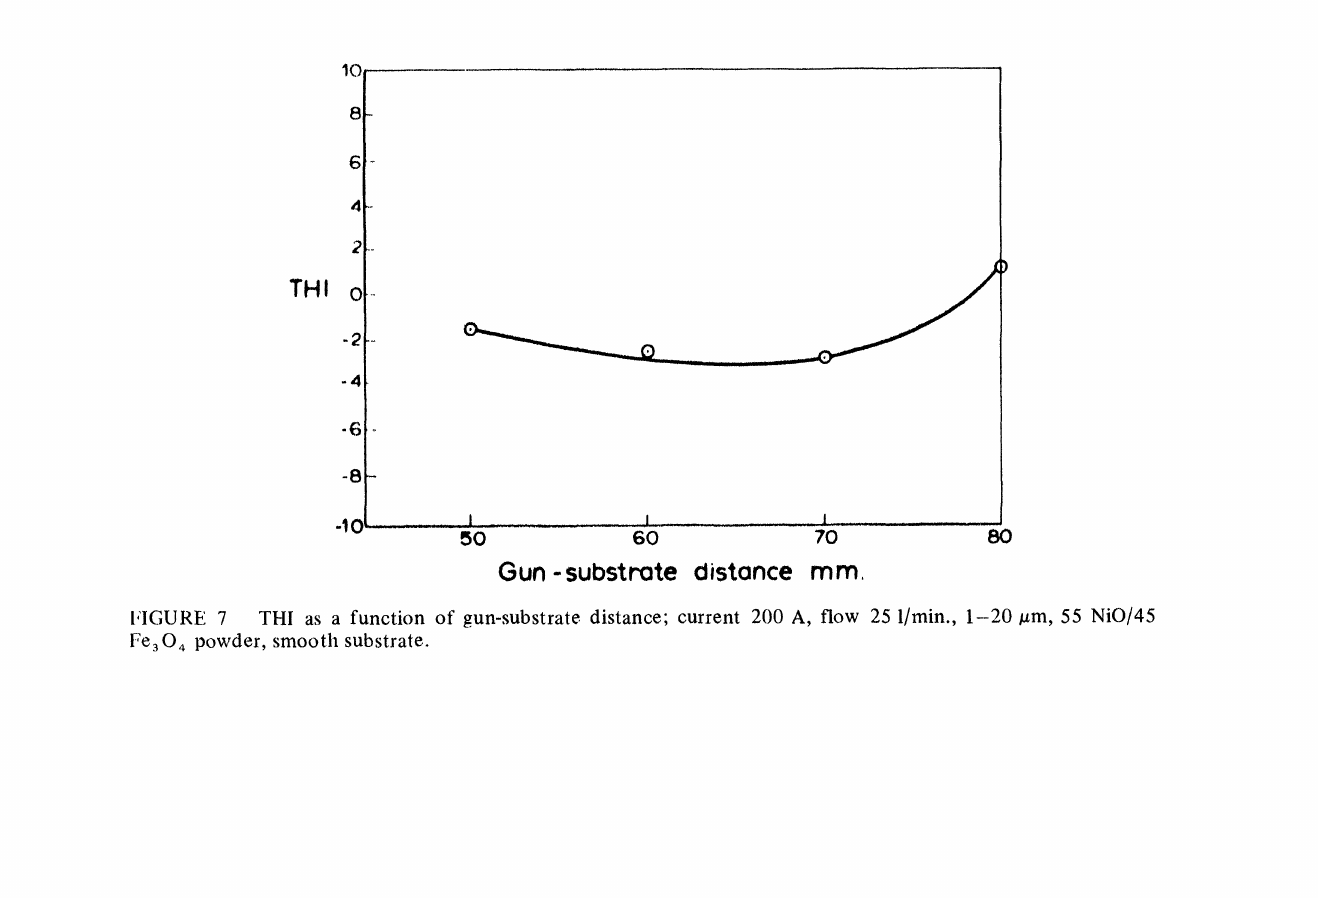
the two powders at the substrate is much the same.